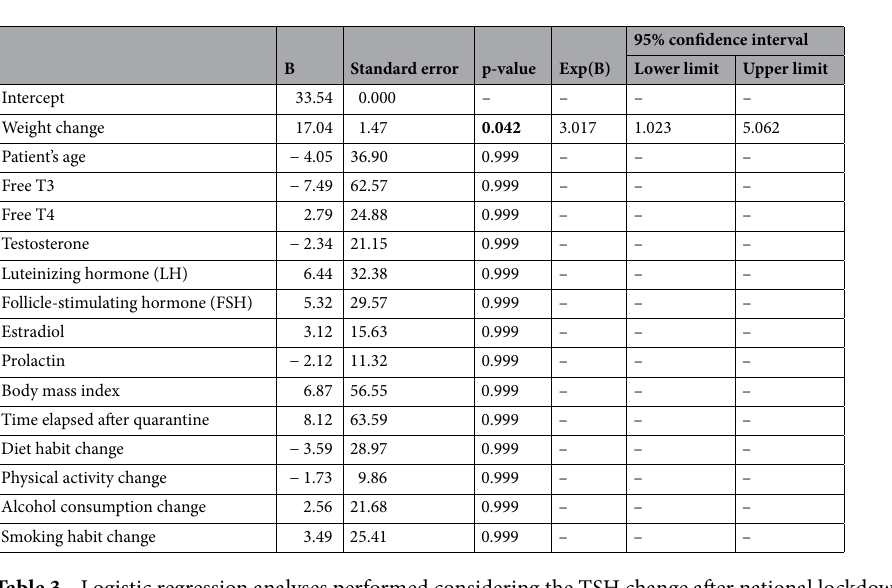
Table 3. Logistic regression analyses performed considering the TSH change after national lockdown as dependent variable. Bold characters represent statistically significant